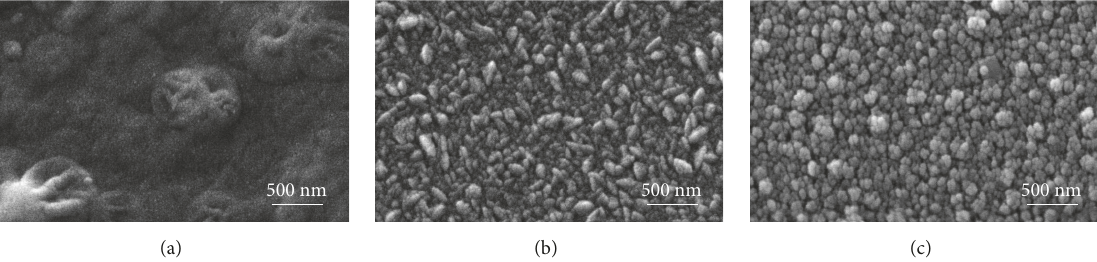
Figure 3: SEM pictures of 200nm thick ZnO thin film deposited at 18keV and distance of 6 cm at substrate temperature of 150 ∘ C (a), 200 ∘ C (b), and 250 ∘ C